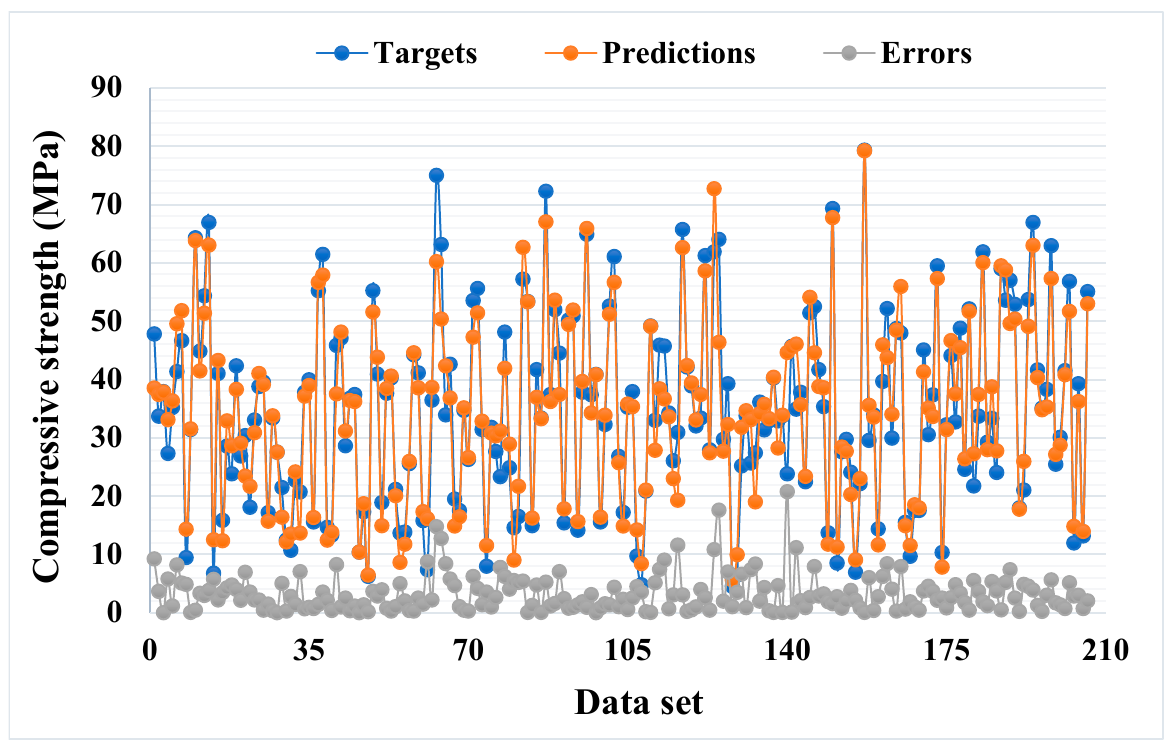
Figure 4. Distribution of actual and predicted values along with the errors for the bagging model.